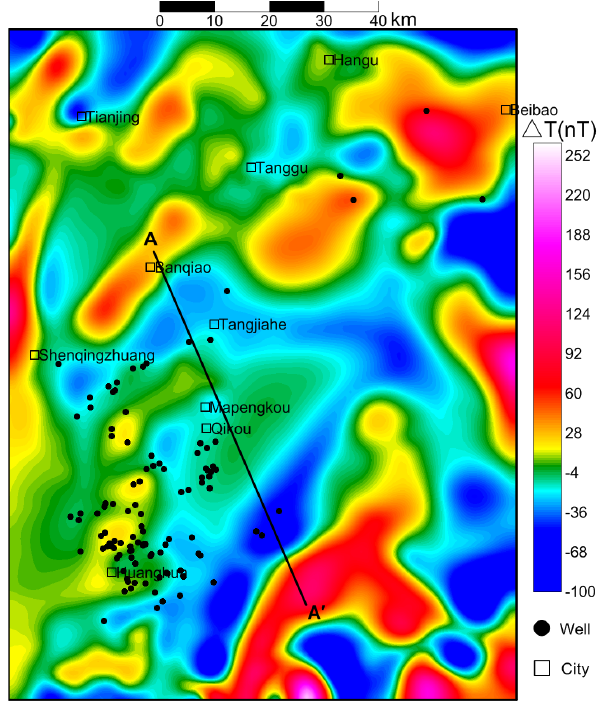
Fig. 8. Local magnetic anomalies extracted by multiscale wavelet analysis, comprising primarily second and third wavelet details after Wu et al.